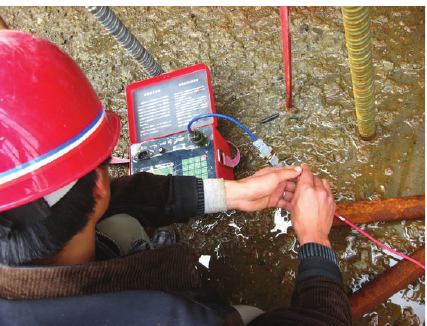
Figure 14: Arrangements of strain gauge and EMI active sensor.